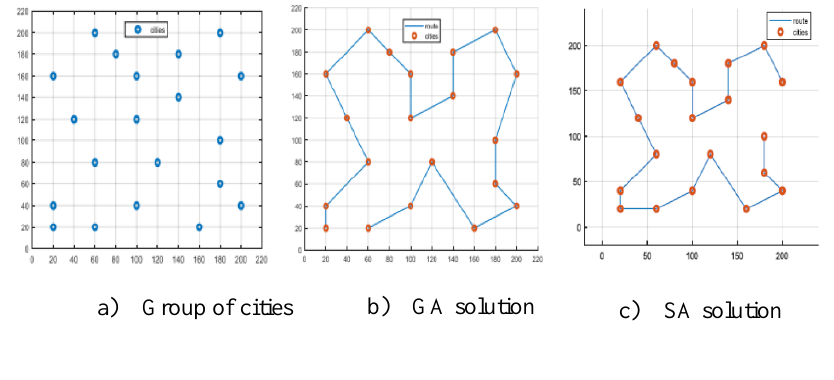
Fig. 1. Simulation